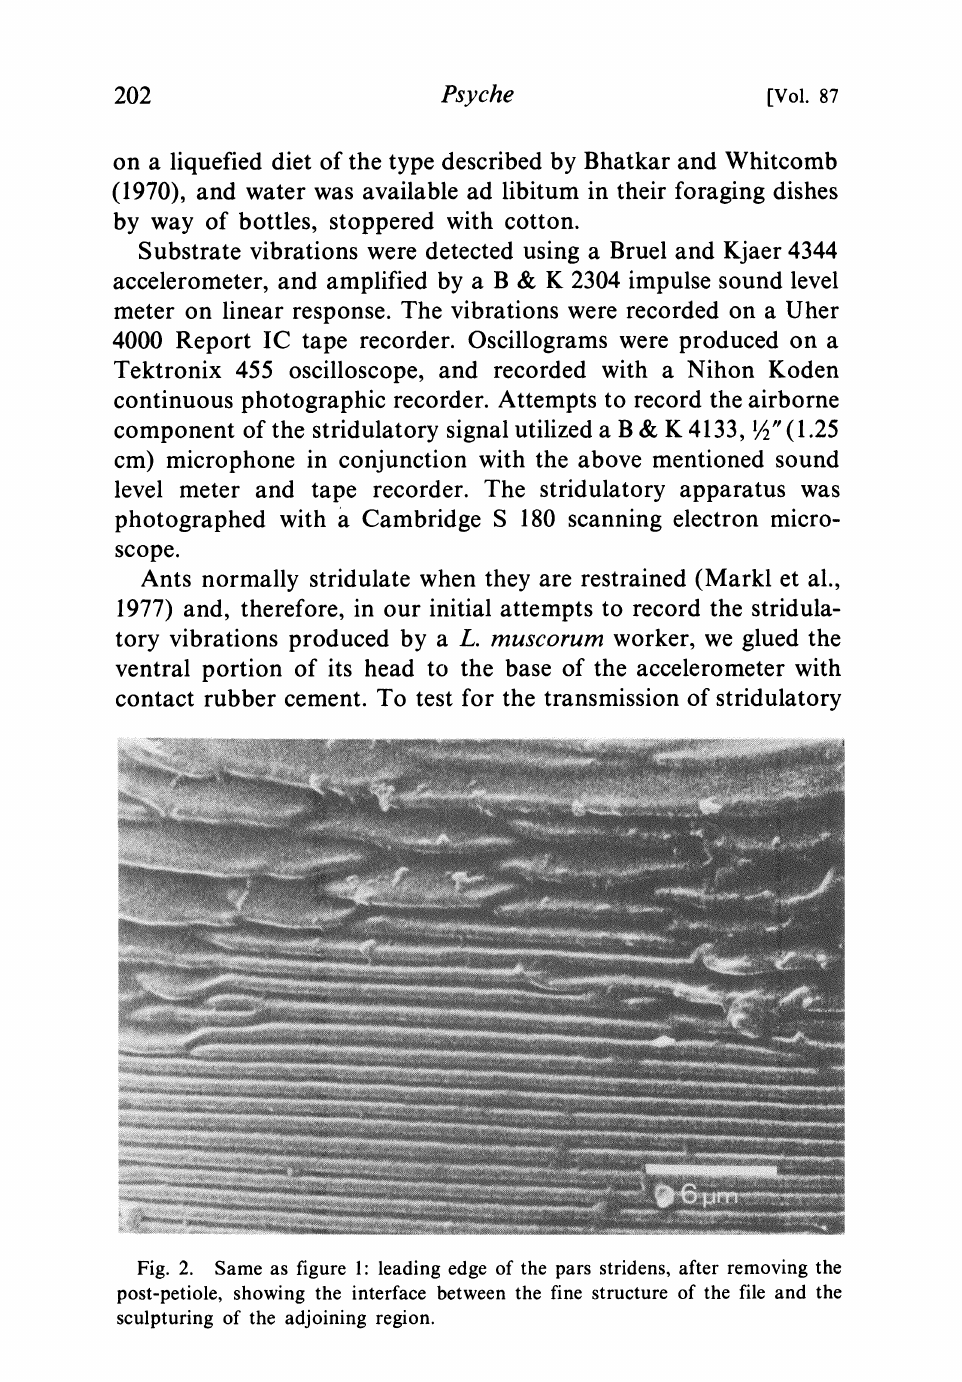
Fig. 2. Same as figure 1: leading edge of the pars stridens, after removing the post-petiole, showing the interface between the fine structure of the file and the sculpturing of the adjoining